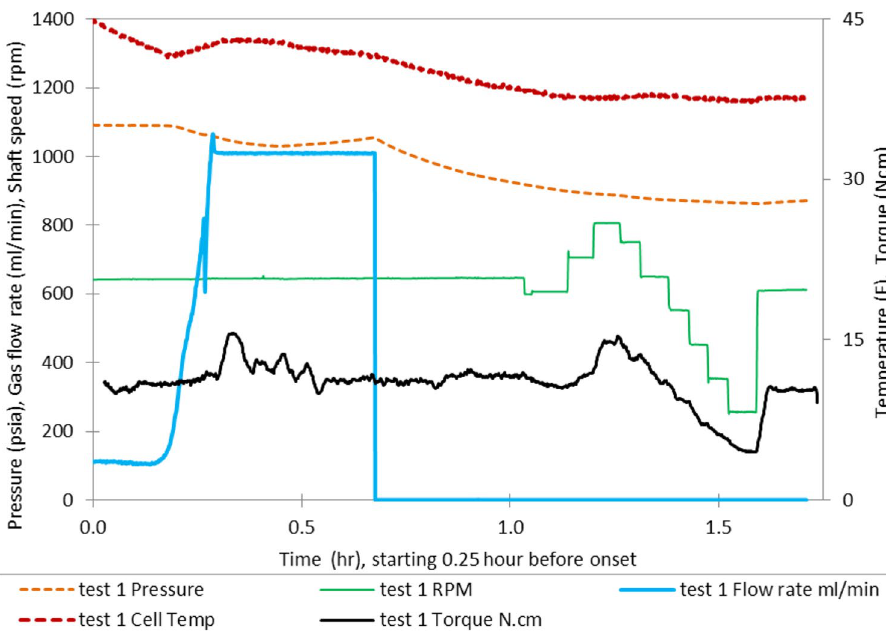
Fig. 12 Typical temperature, pressure, gas, and torque profiles of a kerosene–water hydrate transporting system in a the mixer-viscometer device. This test contains 30% watercut. Initial pressure was 1100 psi at 70 °F. The jacket temperature was decreased from 70 °F